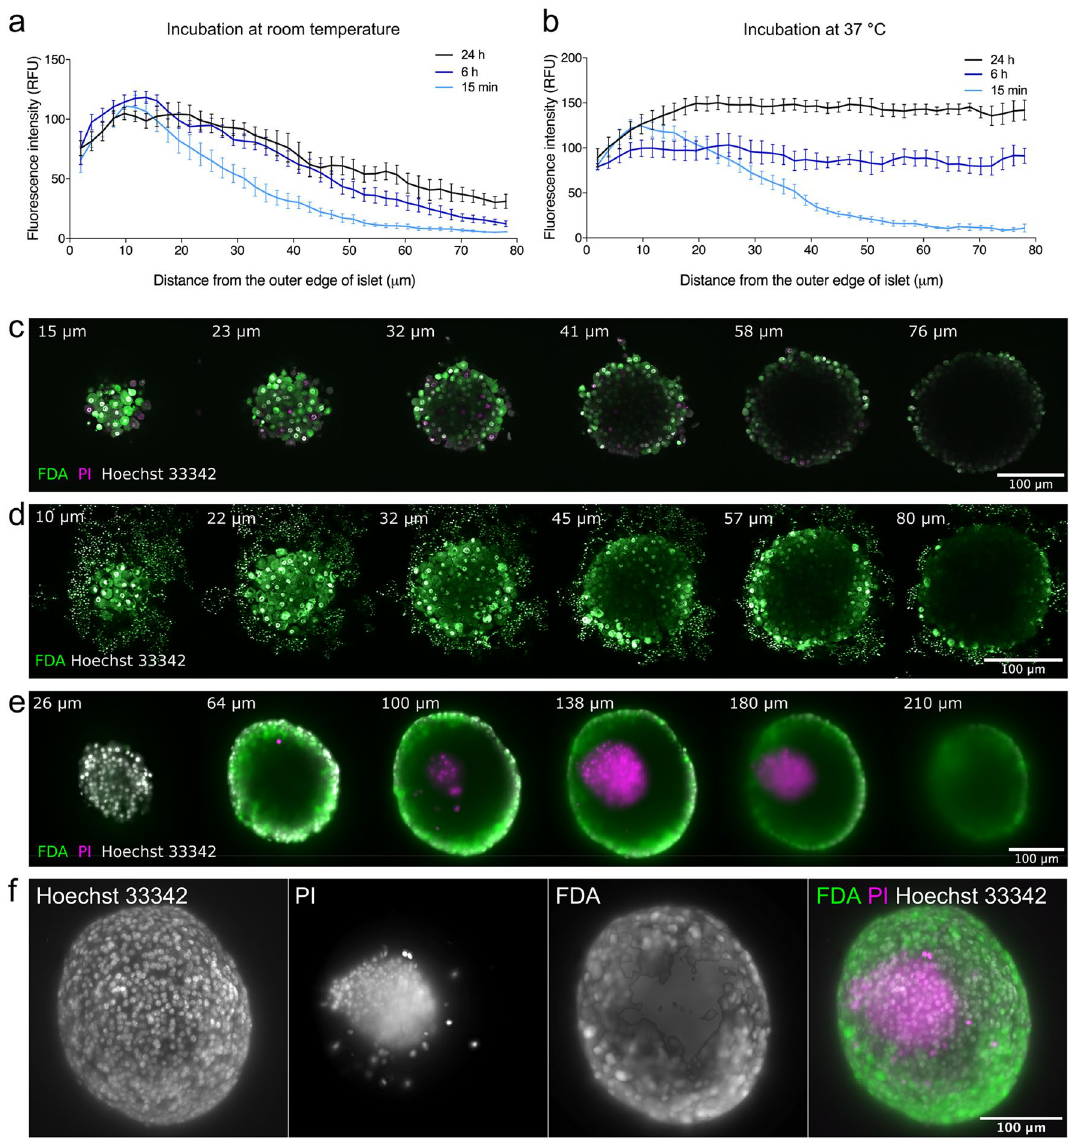
Figure 2. Effect of temperature on diffusion of nuclear dye Hoechst 33342 into pancreatic islets. ( a ) Staining profiles of pancreatic islets incubated with Hoechst 33342 for 15 min, 6 h or 24 h at room temperature (n = 6–7). ( b ) Staining profiles of pancreatic islets incubated with Hoechst 33342 for 15 min, 6 h or 24 h at 37 °C (n = 6–7). ( c ) Pancreatic islet stained with FDA (green), PI (magenta) and Hoechst 33342 (white) for 6 h at 37 °C imaged a confocal microscope. ( d ) Pancreatic islet stained with FDA (green) and Hoechst 33342 (white) for 6 h at 37 °C imaged on a two-photon microscope. ( e ) Pancreatic islet stained with FDA (green), PI (magenta) and Hoechst 33342 (white) for 6 h at 37 °C imaged on a light sheet microscope. ( f ) 3D-reconstruction from multi-angle imaging (4 angles, 90° apart) of pancreatic islet stained with FDA (green), PI (magenta) and Hoechst 33342 (white) using light sheet microscopy. Representative images shown. Figures ( a ) and ( b ) were produced in GraphPad Prism (version 8.4.1, https:// www. graph pad. com). In ( c – a ), each slice is labelled with distance in μm from the top of the islet. FDA fluorescein diacetate, PI propidium